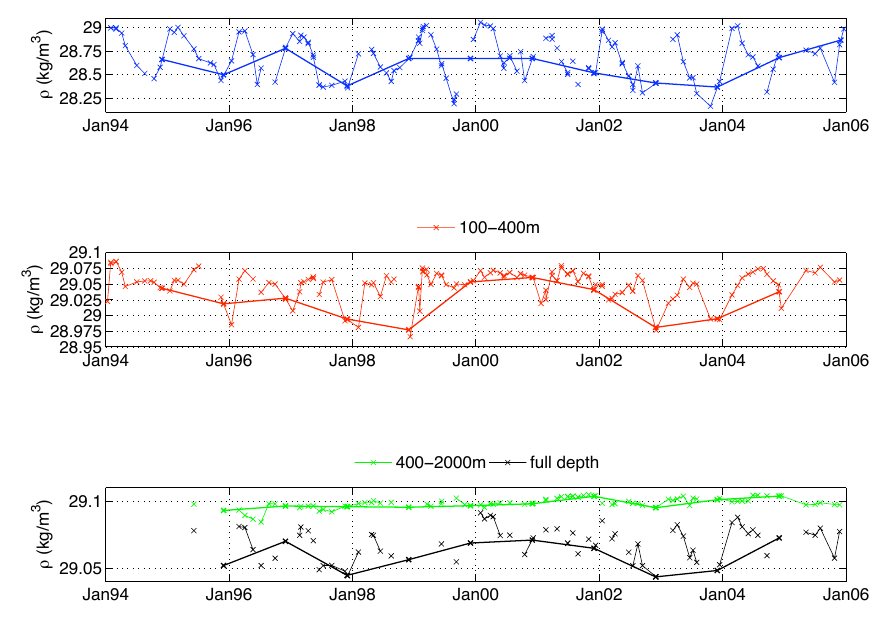
Fig. 6. Potential density from Dyfamed for the 0–100m (top), the 100–400m (middle), the 400–2000m (bottom, green) and the 0–2000m (bottom, black) layers. For each plot, the corresponding thick line joins the interpolated values for the 1 December of each year between Fig. 7. Depth averaged vertical buoyancy gradients for the top, intermediate and bottom layers from the Dyfamed data set. 1995 and